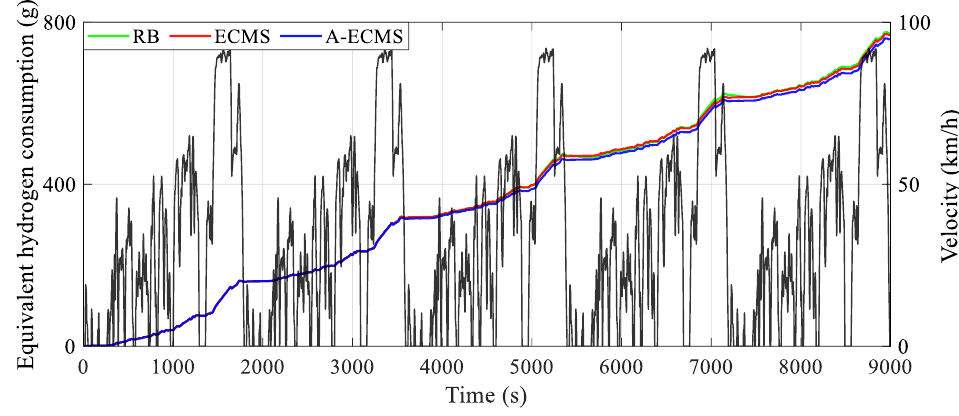
Figure 9. Curves of equivalent hydrogen consumption using different